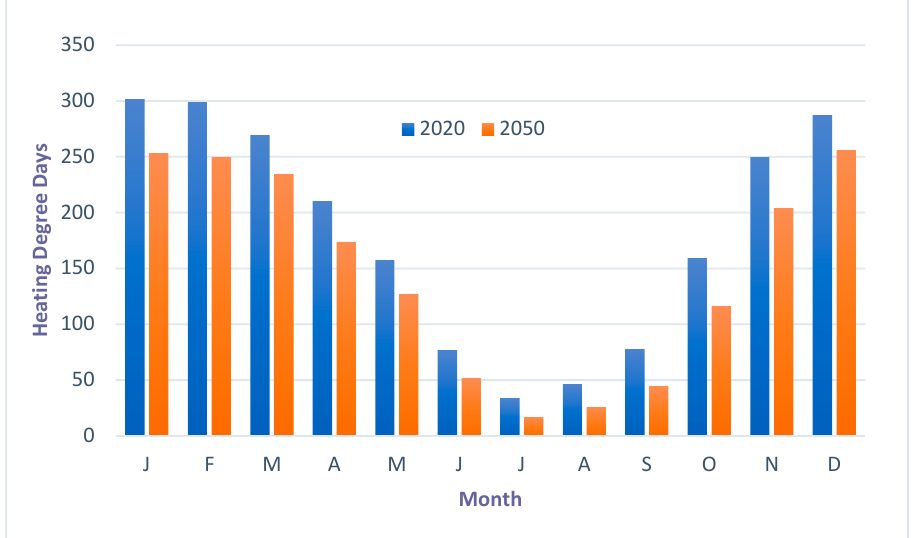
Figure 3. Heating degree days using the current Dublin weather file (2020) and the modified file to represent the impact of climate change (2050).